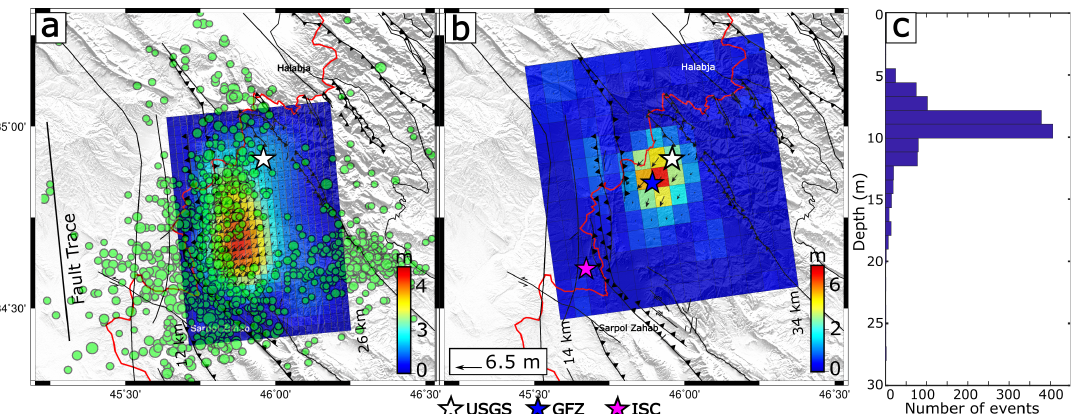
Figure 5. Surface projection of the coseismic slip distribution retrieved from ( a ) InSAR observations and ( b ) teleseismic waveform data. Black arrows denote slip directions of each fault patch on the hanging wall. Green dots in ( a ) are aftershocks (M w > 2.5) in the first 60 days following the earthquake, obtained from the IRSC. The white, blue, and magenta stars mark the USGS, GFZ, and International Seismological Centre (ISC) locations, respectively, for the main shock epicenter. ( c ) Histogram of the aftershock with depth distribution reported by the IRSC catalog (M w > 2.5) showing concentration of the aftershocks in a depth range of 7–12